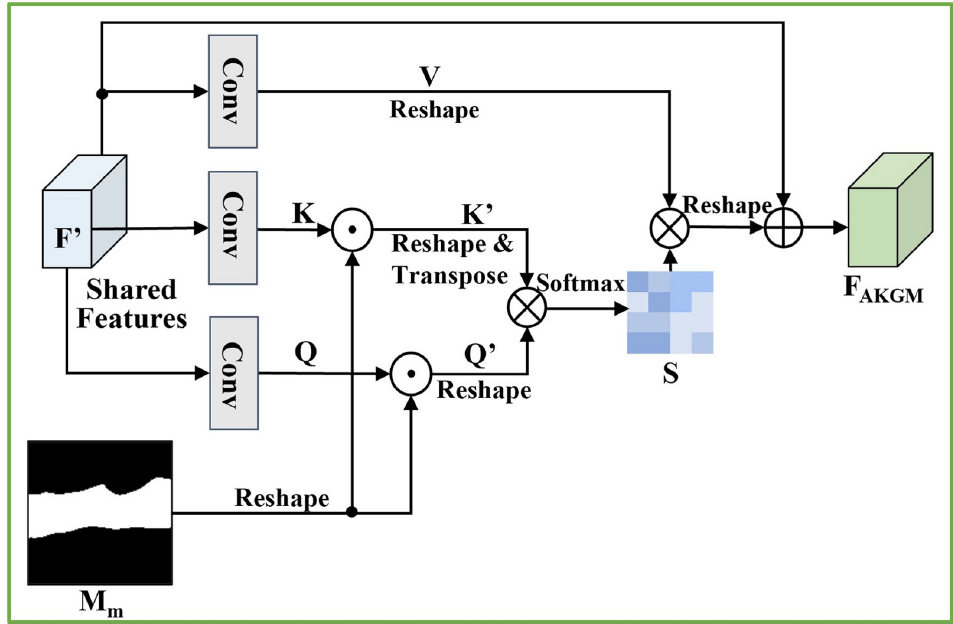
Fig 8. Schematic of the Anatomical Knowledge Guidance Module (AKGM). � denotes element-wise multiplication, � denotes matrix multiplication and � denotes element-wise addition. Conv indicates that the features have passed through a convolutional